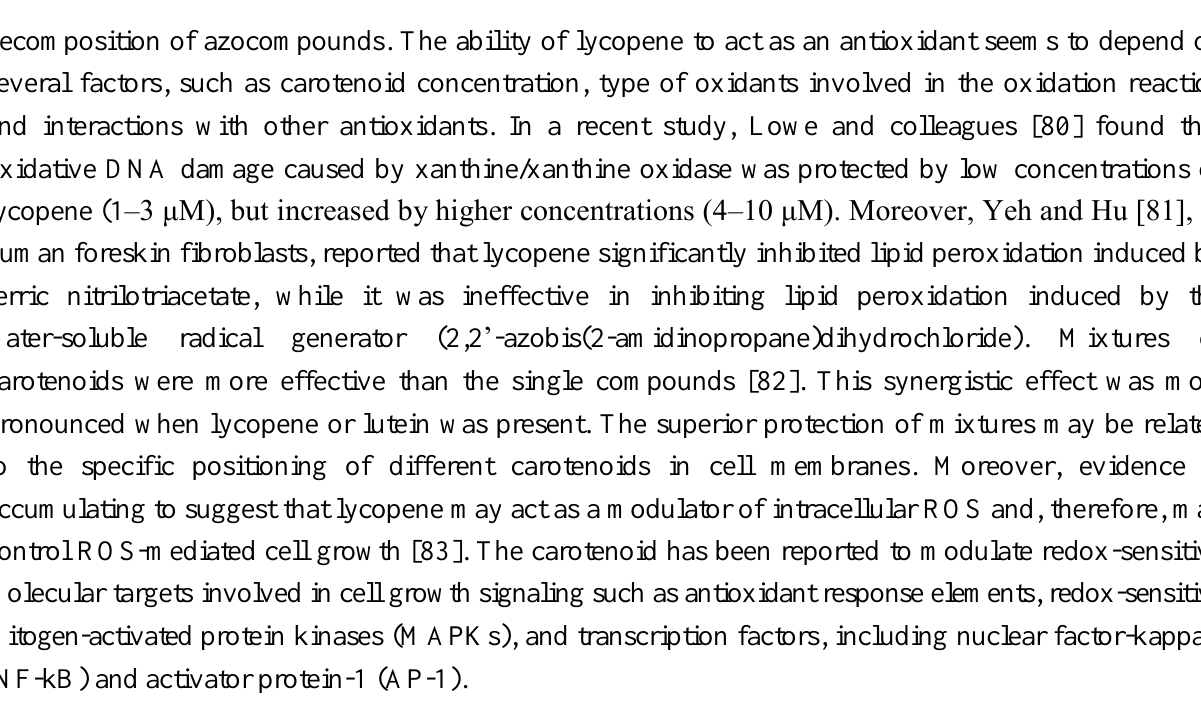
Figure 2. Potential mechanisms of lung cancer prevention by